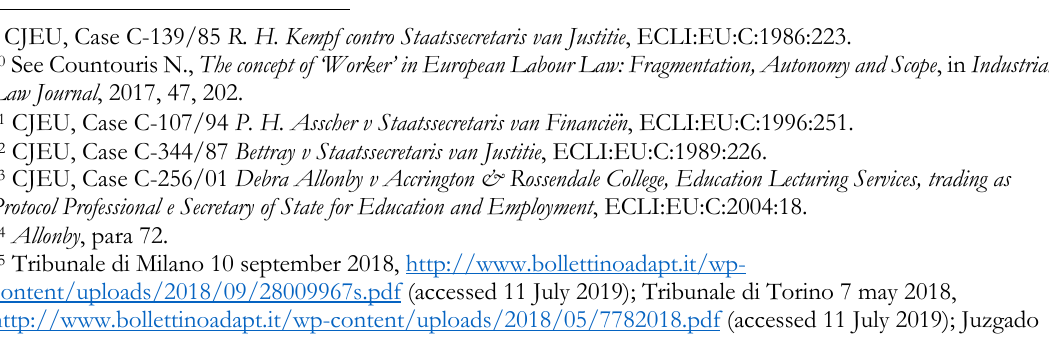
Protocol Professional e Secretary of State for Education and Employment , ECLI:EU:C:2004:18.